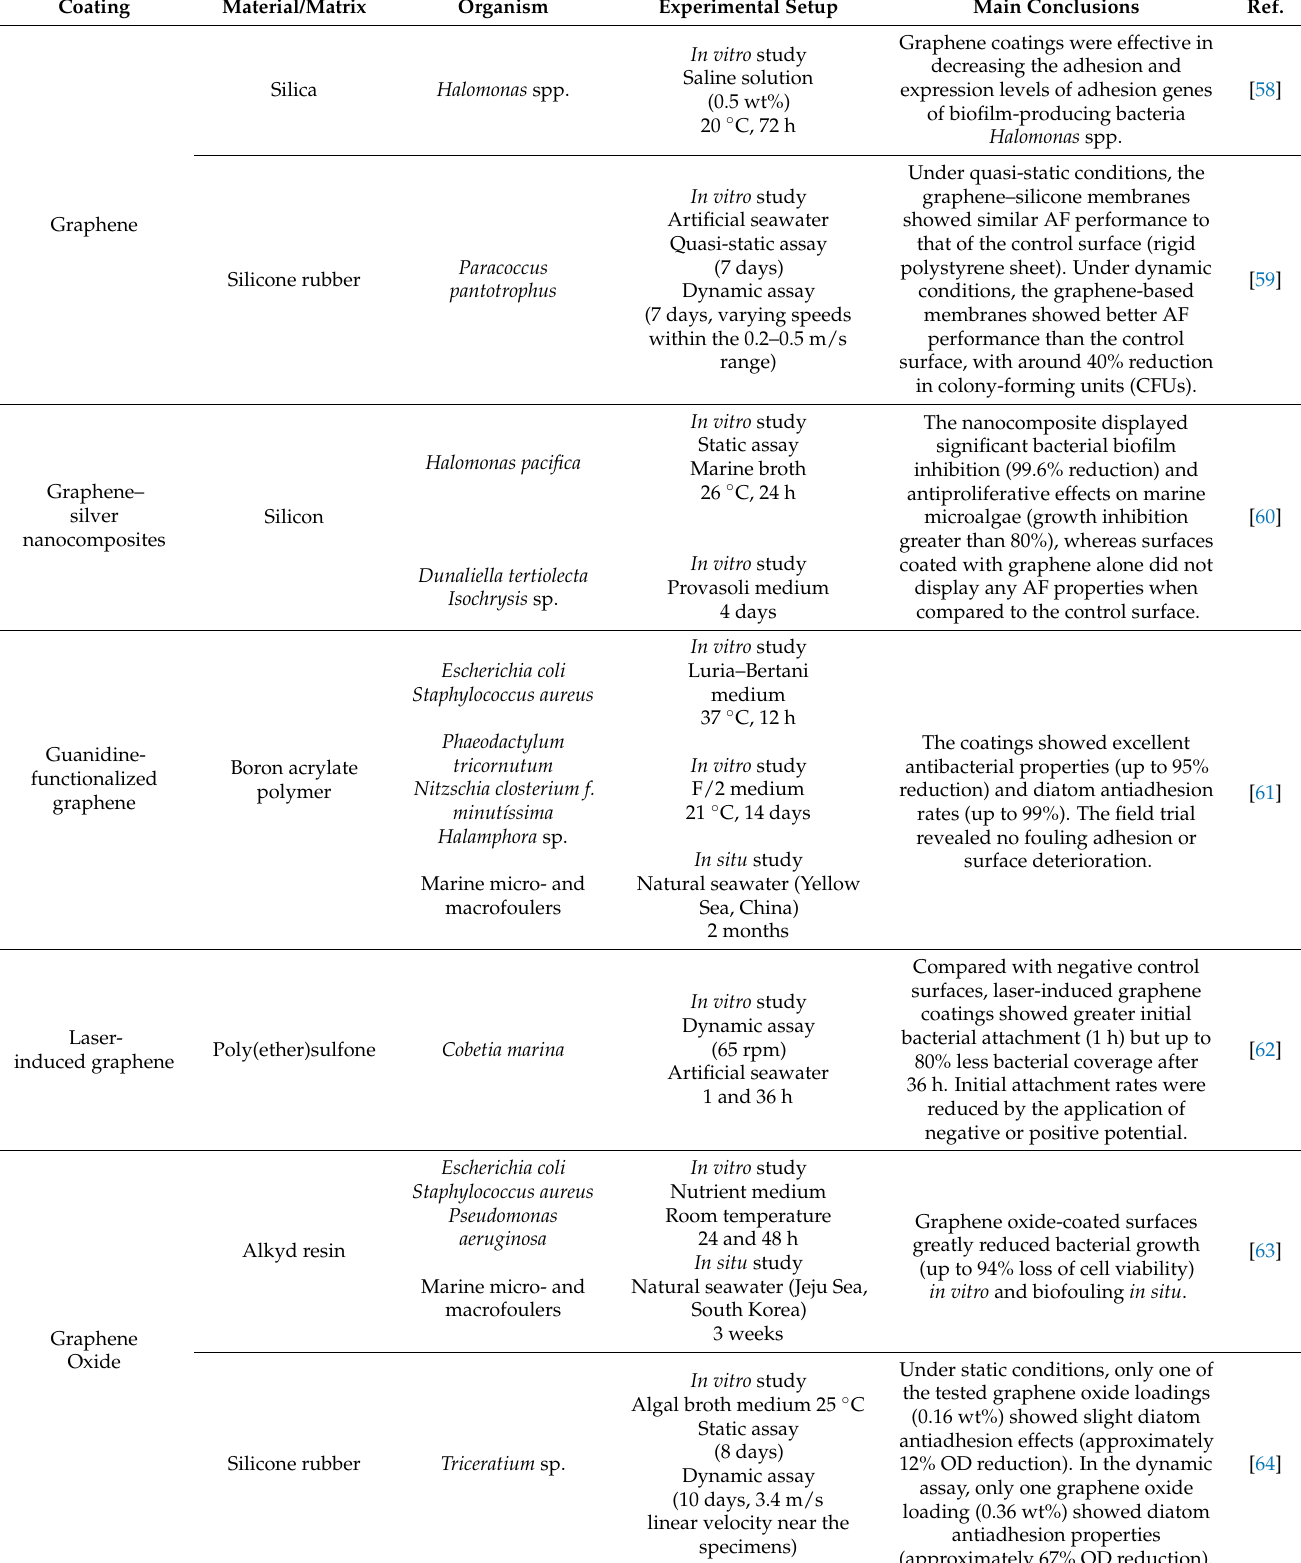
Table 1. Studies focused on graphene-based AF coatings in marine